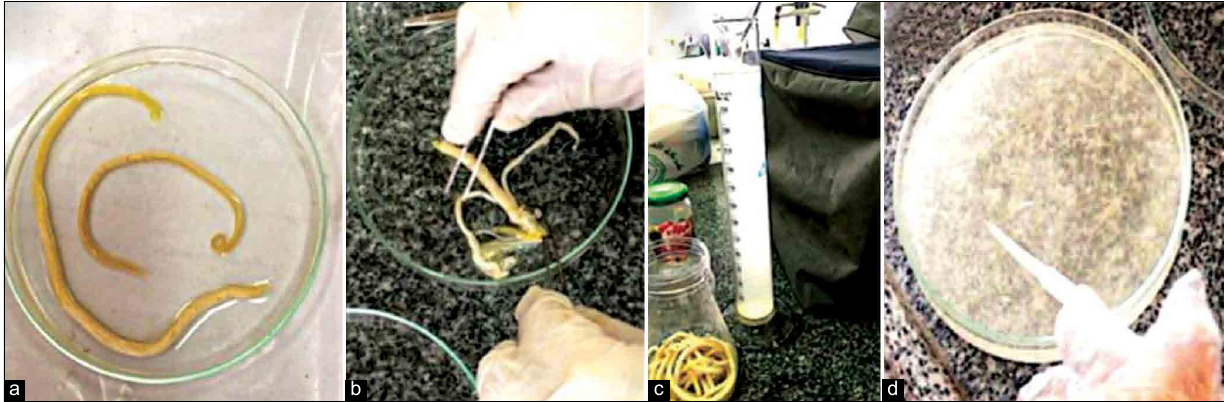
Figure-1: Collection of Toxocara vitulorum egg. (a) Collected T. vitulorum from the jejunum of naturally infected buffalo calves. (b) Eggs were collected from the adult female worms’ uteri and (c) leave for sedimentation in normal saline. (d) The collected eggs were incubated in Petri dishes with 0.5% formalin solution at room temperature for 15-45 days with infrequent agitation and inspection.